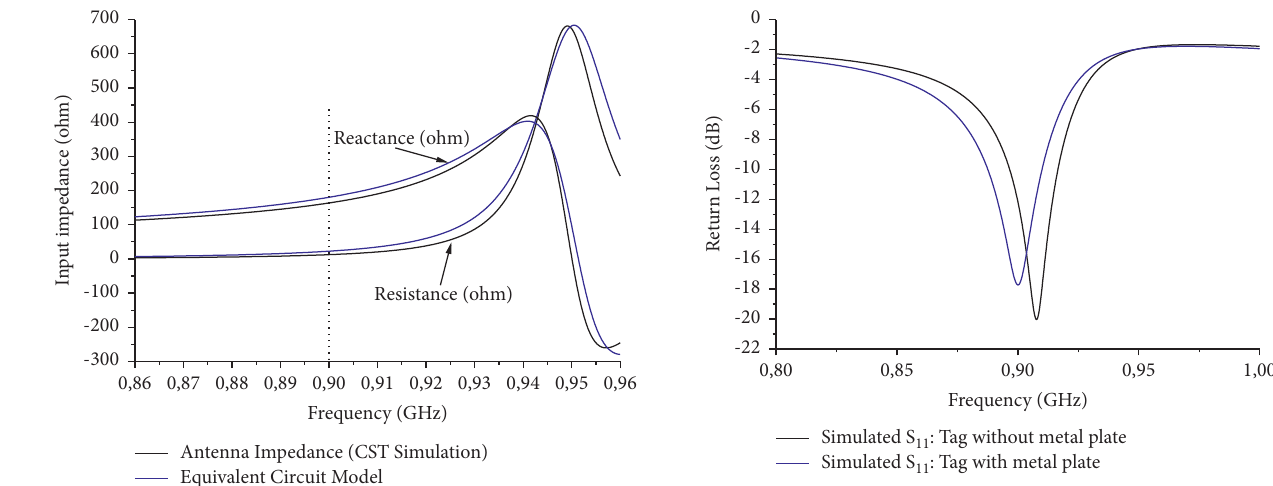
Figure 2: Equivalent circuit of the proposed 3D PILA tag antenna ( R L sst � 29.68nH, and C g � 0.15pF).